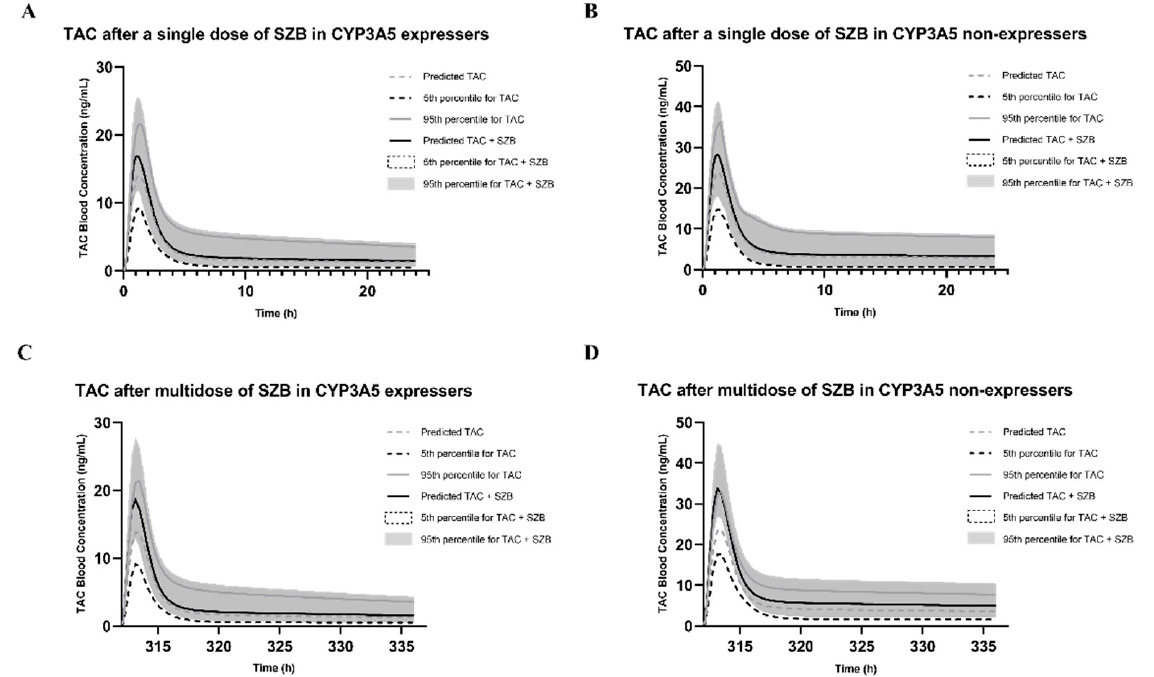
Figure 7 . Change in tacrolimus exposure after a single dose of 33.6 mg SZA in CYP3A5 expressers ( A ) and CYP3A5 non-expressers ( B ); and after multiple doses of SZA (16.8 mg b.i.d. for 13.5 days) in CYP3A5 expressers ( C ) and CYP3A5 non-expressers ( D ).